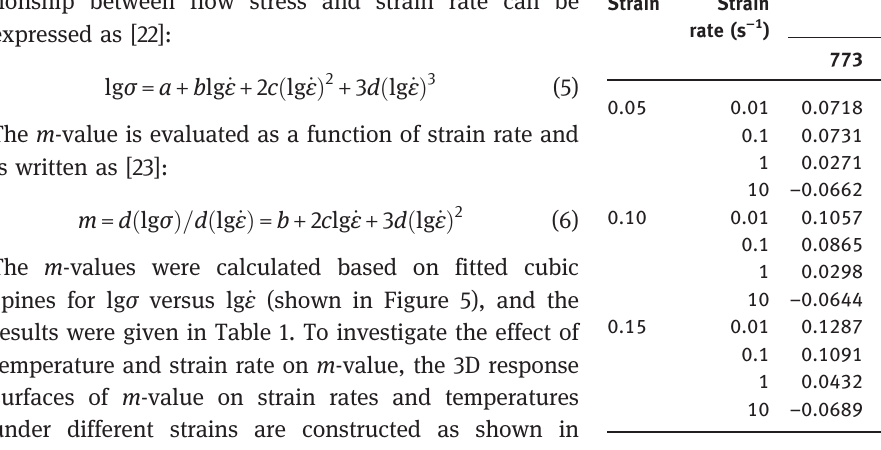
Table 1: m -value at different temperatures, strains and strain rates. Strain